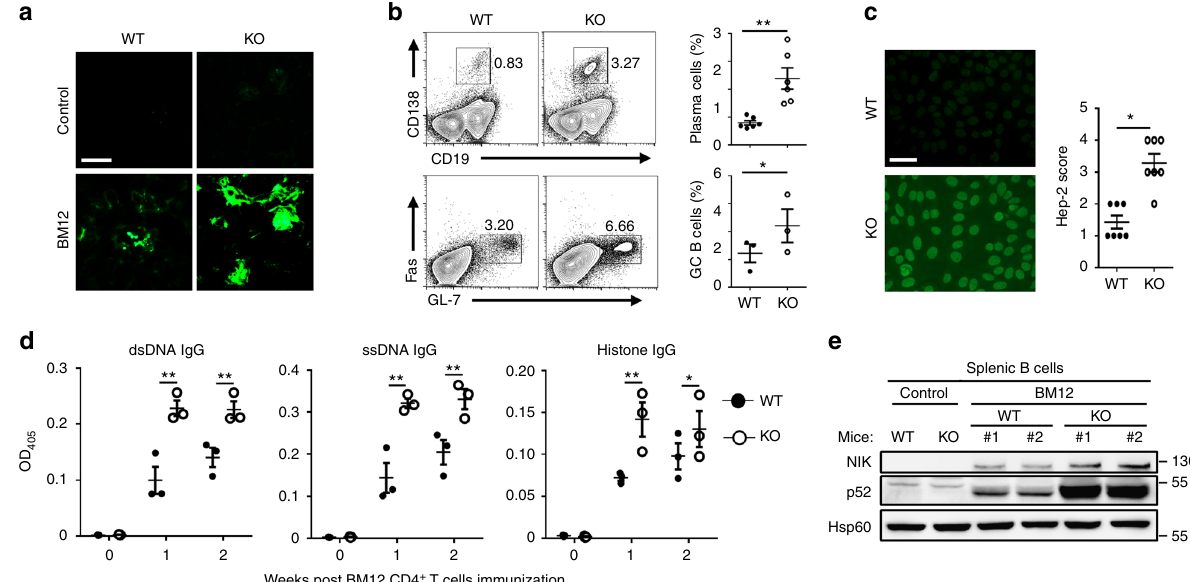
Fig. 2 Peli1 de fi ciency aggravates the induction of lupus-like disease. a WT and Peli1 -de fi cient (KO) mice were intraperitoneally injected with 7.5 million of CD4 + T cell from C57BL/6 mice (control) or from BM12 mice. Representative immuno fl uorescent images showing IgG deposits in kidney by staining with Alexa Fluor 488-labeled anti-mouse IgG. Scale bar, 100 μ m. b Flow cytometric analysis of the percentages of CD19 − CD138 + plasma cells and Fas + GL-7 + germinal center (GC) B cells in WT and KO immunized mice as described in ( a ). Data are presented as a representative plot (left panel) and summary graph (right panel). c Distinct anti-nuclear antibody (ANA) staining patterns of the Hep-2 cell line with serum from WT and KO mice 4 weeks after immunization as described in ( a ). Scale bar, 50 μ m. d Enzyme-linked immunosorbent assay (ELISA) of anti-dsDNA, anti-ssDNA, and anti-histone IgG in serum from WT and KO immunized mice as described in ( a ) at the indicate time point. e Immunoblot showing NIK and p52 protein levels in splenic B cells from control and BM12 CD4 + T cells immunized WT and KO mice as described in ( a ). Data are shown as the mean ± SEM based on three independent experiments. Two-tailed Student ’ s t- tests were performed. * P < 0.05 and ** P <